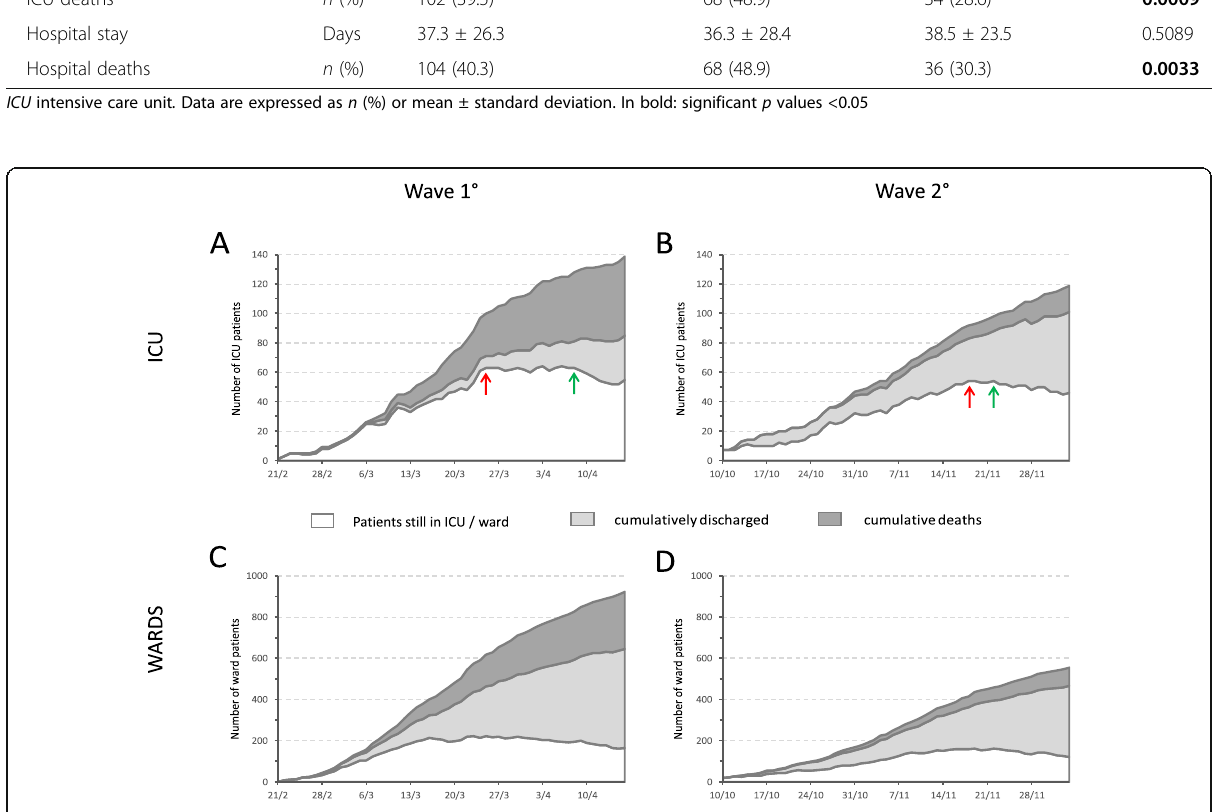
Fig. 1 The first 8 weeks of the two pandemic waves in ICU and in the wards: this timeframe was representative of the critical phase for our healthcare system, including rapid increase of ICU patients up to a peak (red arrows), plateau phase, and initial decline (green arrows). A Wave 1 in ICU. A steep increase of ICU COVID-19 patients was observed until a peak of 64; pre-pandemic capacity was 32 beds. The peak was reached on day 34; a plateau phase persisted until day 48; thereafter, a reduction was observed. After 8 weeks, 139 patients had been admitted to ICU (13.1% of hospital admissions) with 55 (39.6%) patients still in ICU, 30 (21.6%) discharged and 54 (38.8%) deceased. At this time, mortality was 54/84 (64.3%) in ICU patients. B Wave 2 in ICU. The initial increase was slower, and a lower peak (54 ICU patients) was achieved on day 40; a plateau phase lasted until day 44, when the decline started. After 8 weeks, 119 patients had been admitted to ICU (17.7% of hospital admissions, p = 0.0104 vs. wave 1) with 45 (37.8%) patients still in ICU, 56 (47.1%) discharged, and 18 (15.1%) cumulative deaths ( p <0.0001 vs. wave 1). At this time, mortality was 18/74 (24.3%) in ICU patients ( p <0.0001 vs. wave 1). C Wave 1 in the wards. After 8 weeks, 923 patients had been admitted (86.9% of hospital admissions) with 175 (19.0%) patients still in the ward, 475 (51.5%) discharged, and 273 (29.6%) deceased. At this time, mortality was 273/748 (36.5%) in ward patients. D Wave 2 in the wards. After 8 weeks, 555 patients had been admitted (82.3% of hospital admissions, p= 0.0104 vs. wave 1) with 134 (24.1%) patients still in the ward, 334 (60.2%) discharged and 87 (15.7%) deceased (p<0.0001 vs. wave 1). At this time, mortality was 87/421 (20.7%) in ward patients (p<0.0001 vs. wave